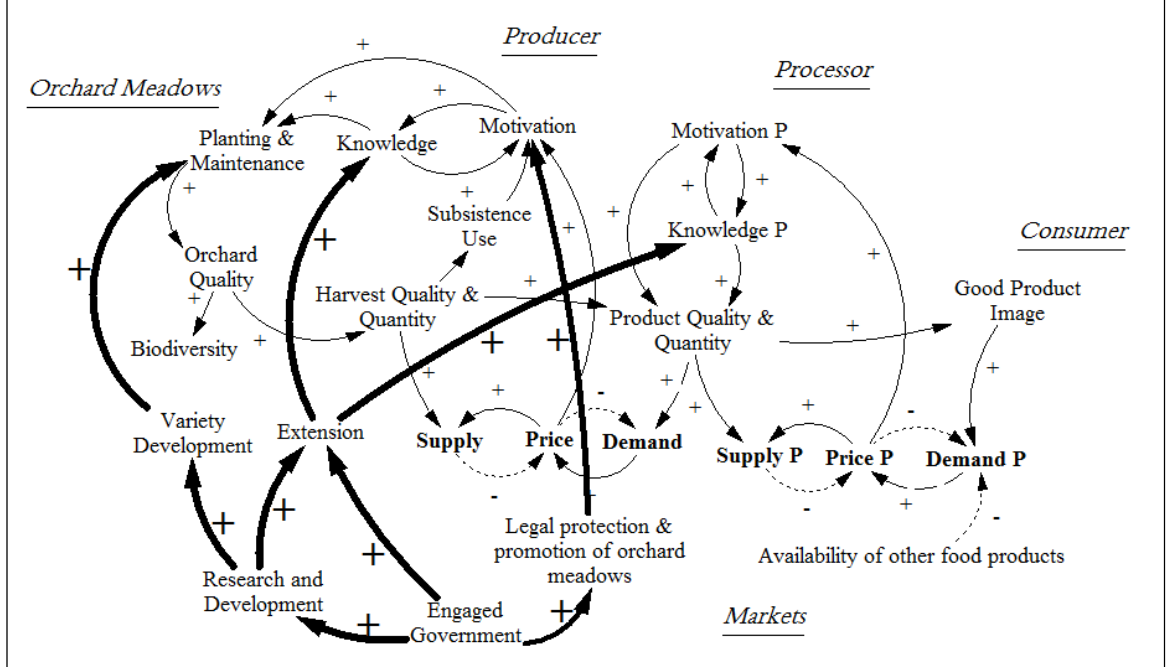
Figure 7. The Role Government Support Played in the Establishment and Maintenance of Orchard Meadows in Baden-Württemberg from the 16 th to the Mid-20 th Century The same drivers and relationships were involved in the rise of orchard meadows as are today involved in its decline; the basic conceptual model does not change. However, in the past the involvement of government through research & development, extension, and laws drove the feedback cycles of the system such that orchard meadows